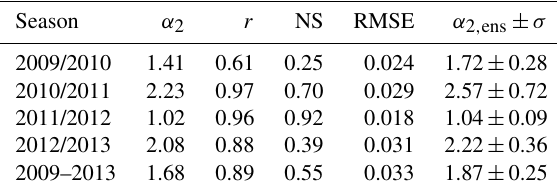
Table 4. Results for the parameter α 2 determined for each season independently and for all seasons together. The agreement between model and radar anisotropy is given by the Pearson’s correlation co- efficient ( r ), the Nash–Sutcliffe model efficiency coefficient (NS), and the root-mean-square error (RMSE). The last row contains the mean and standard deviation of α 2 from the ensemble